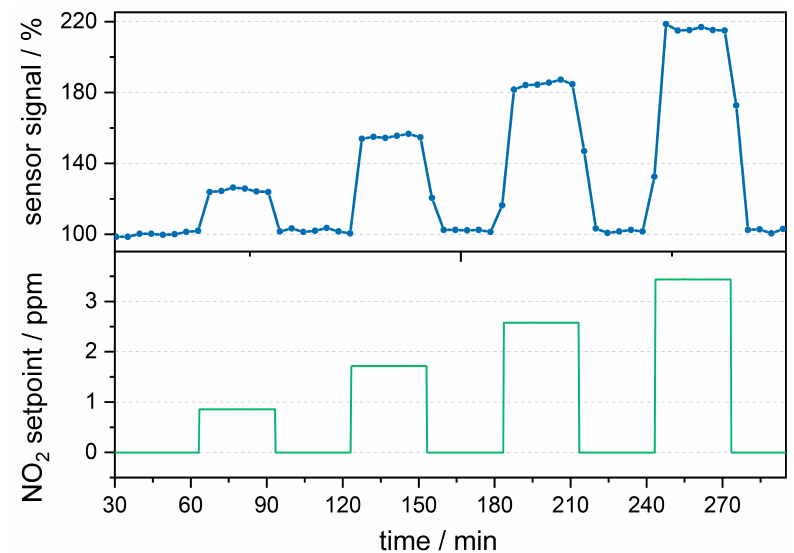
Figure 7. Time resolved gas measurement result of the photoacoustic sensor normalized to the zero concentration. Due to the sweep over the complete resonance peak the data rate is around 0.25 min − 1 . The noise analysis showed a noise equivalent (1 σ ) of approximately 32 ppb. Therefore the sensor can detect concentrations of around 200 ppb with 6 σ confidence.